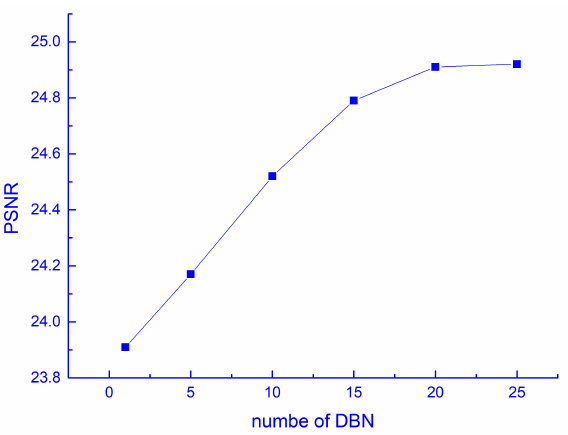
Figure 12. The influence of DBN numbers on performance of PSNR.